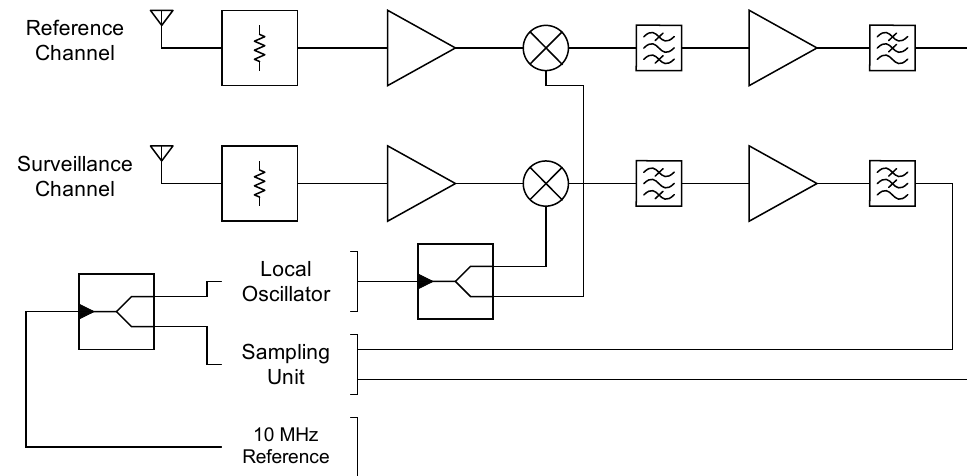
Figure 2. The dual-channel receiver developed for the bistatic radar measurements with a reference channel for the reception of the direct signal and a surveillance channel for the clutter reception.